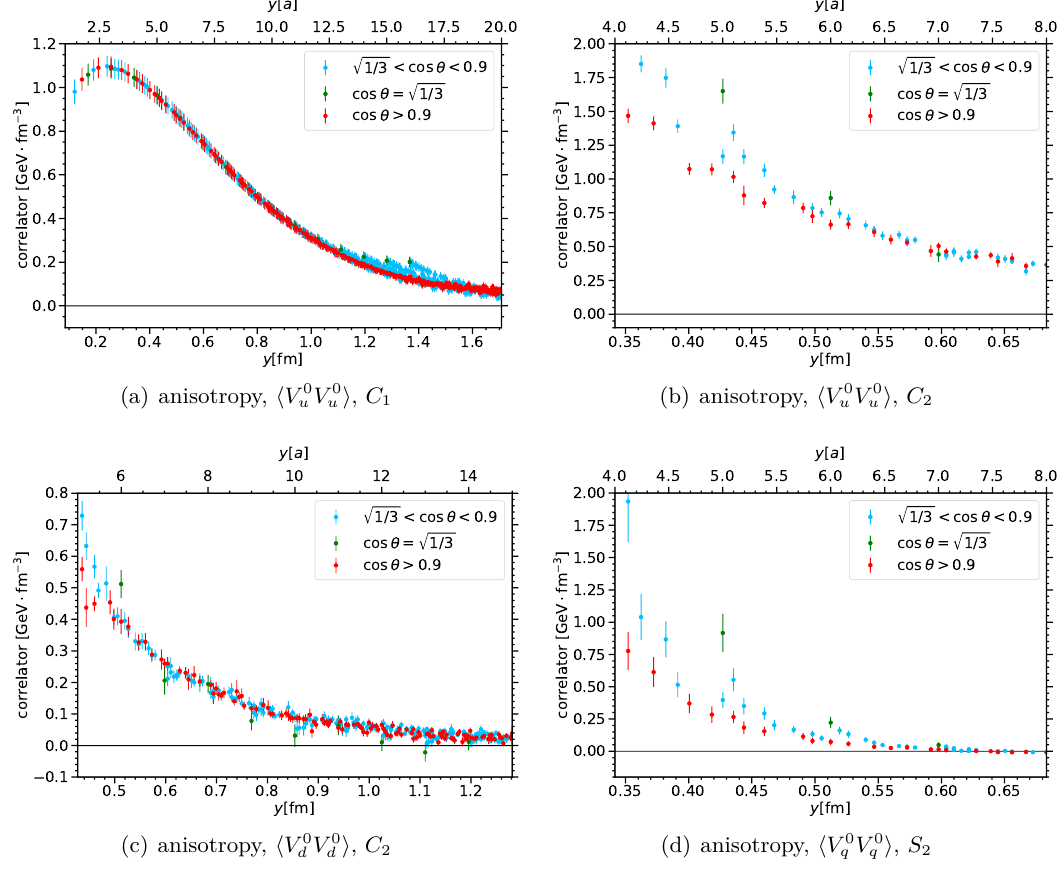
Figure 7 . Visualization of anisotropies found in the four-point data. The data points are separated w.r.t. to the angle θ between the distance vector ~y and the next nearest space diagonal (see the text). These plots show the results for the C h V 0 V 0 i for small y (b) and h V 0 u u